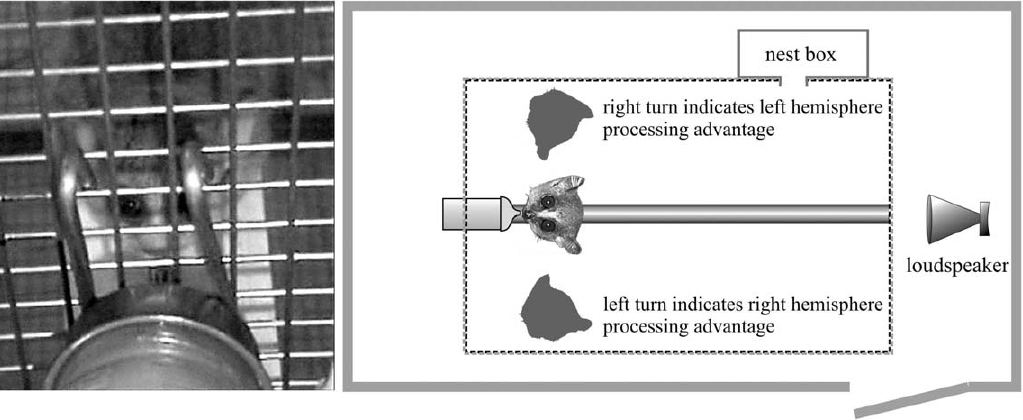
Figure 2. Experimental set-up (right) and defined head position (left). (adapted from Scheumann and Zimmermann, 2008).